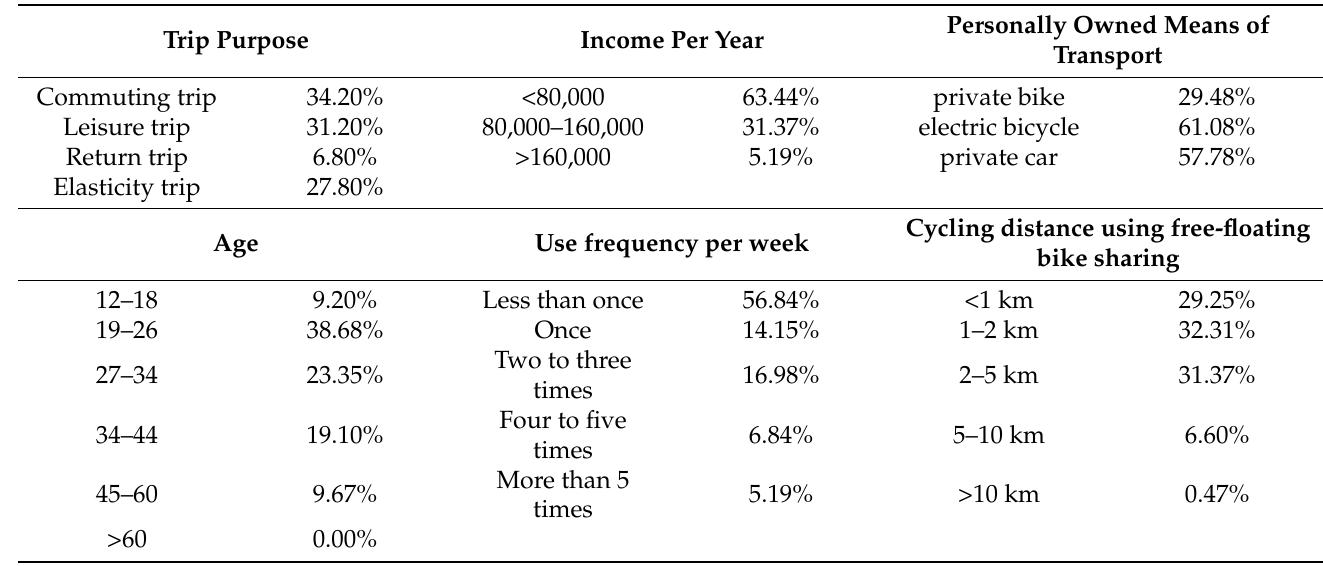
Table 3. Demographics and usage characteristics of sample for Pattern 1.